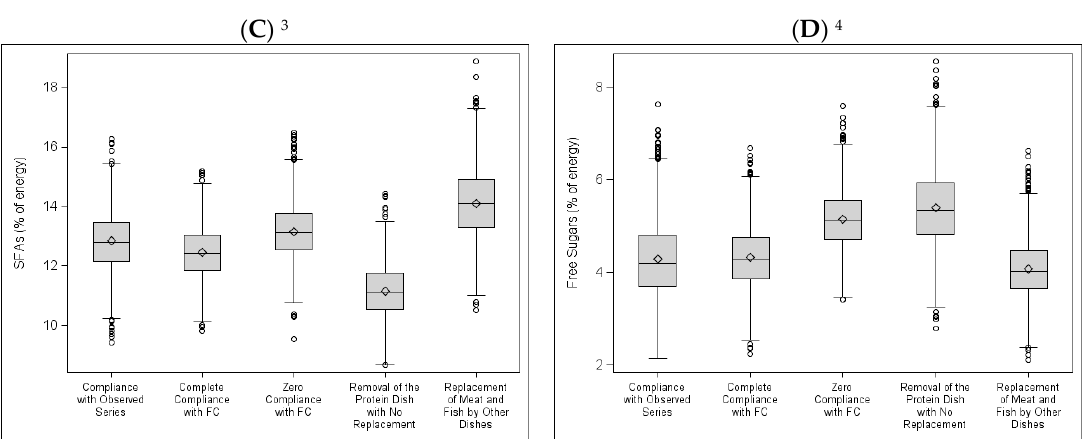
Figure 4. Nutritional quality of simulated series according to five scenarios: Box Plots ( A ) Mean Adequacy Ratio (MAR, % of adequacy for 2000 kcal); ( B ) Fats (% of energy); ( C ) Saturated Fatty Acids (SFAs, in % of energy); ( D ) Free Sugars (% of energy). 1 For MAR/2000 kcal, the averages are statistically different ( p < 0.05) from one series to another. 2 For fats (% of energy), the averages are statistically different ( p < 0.05) from one series to another, except between “Zero Compliance with FC” and “Replacement of Meat and Fish with Other Dishes”. 3 For SFAs (% of energy), the averages are statistically different from one series to another ( p < 0.05). 4 For free sugars (% of energy), the averages are statistically different ( p < 0.05) from one series to another except between “Complete Compliance with FC” and “Compliance with Observed Series”, and between “Complete Compliance with FC” and “Replacement of Meat and Fish with Other Dishes”.